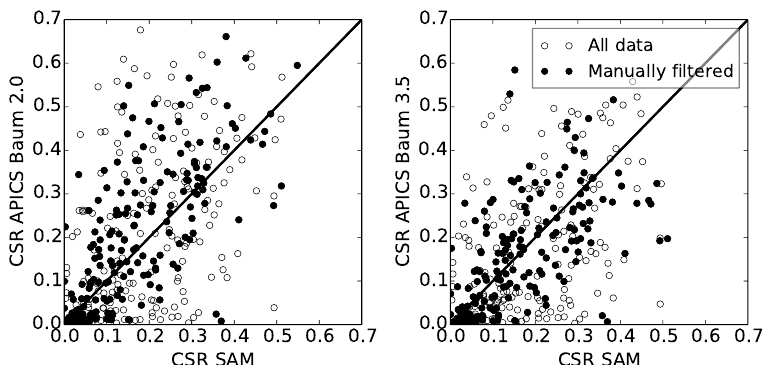
Fig. 10. Scatter plots for the shortened validation time series (May 2011–Jun. 2011). Left panel: CSR retrieved using “Baum v2.0”. Right panel: CSR retrieved using “Baum v3.5”. Filled circles indicate that the data pair has passed the manual cumulus cloud screening on the basis of all-sky images.